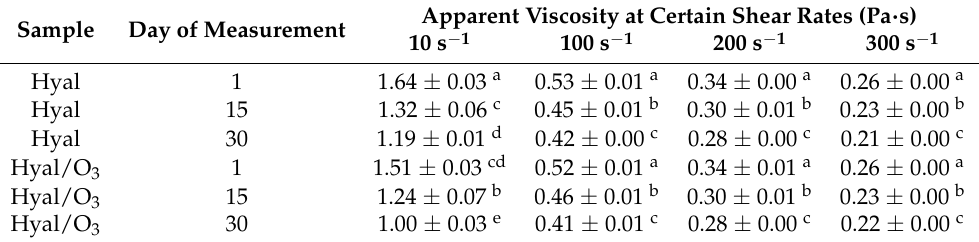
Table 2. Apparent viscosity of the gels at different shear rates.